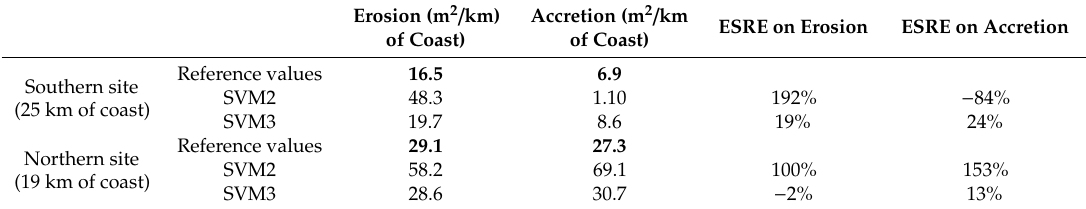
Table 2. Relative false negative and positive errors (in %) for the four WorldView-2 images. SVM2 stands for SVM classification with 2 classes and SVM3 stands for SVM classification with 3 classes. Reference values of erosion and accretion for each site are displayed in